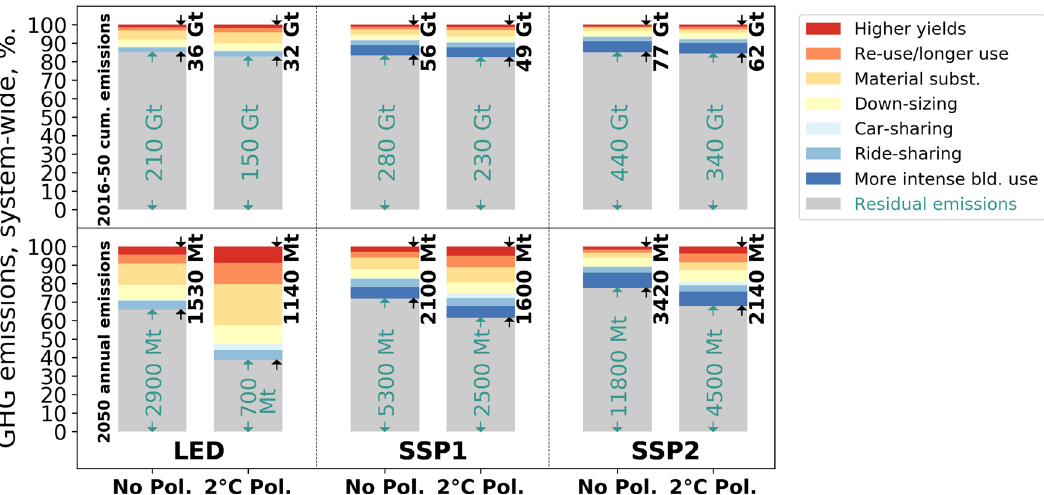
Fig. 1 Total global cumulative (top) and annual 2050 (bottom) greenhouse gas (GHG) emission reductions of the technical potential of ten industrial and demand-side material ef fi ciency (ME) strategies. Results are shown for three socioeconomic (low energy demand (LED) and the shared socioeconomic pathways (SSP1 and SSP2)), and climate policy (No Pol. and 2 °C Pol., see text) scenarios and ME strategy for the passenger-vehicle and residential-building sectors combined. The absolute values in the plot are in megatons (Mt) or gigatons (Gt) of CO 2 -eq. See the ‘ Methods ’ section for an overview of the different ME strategies